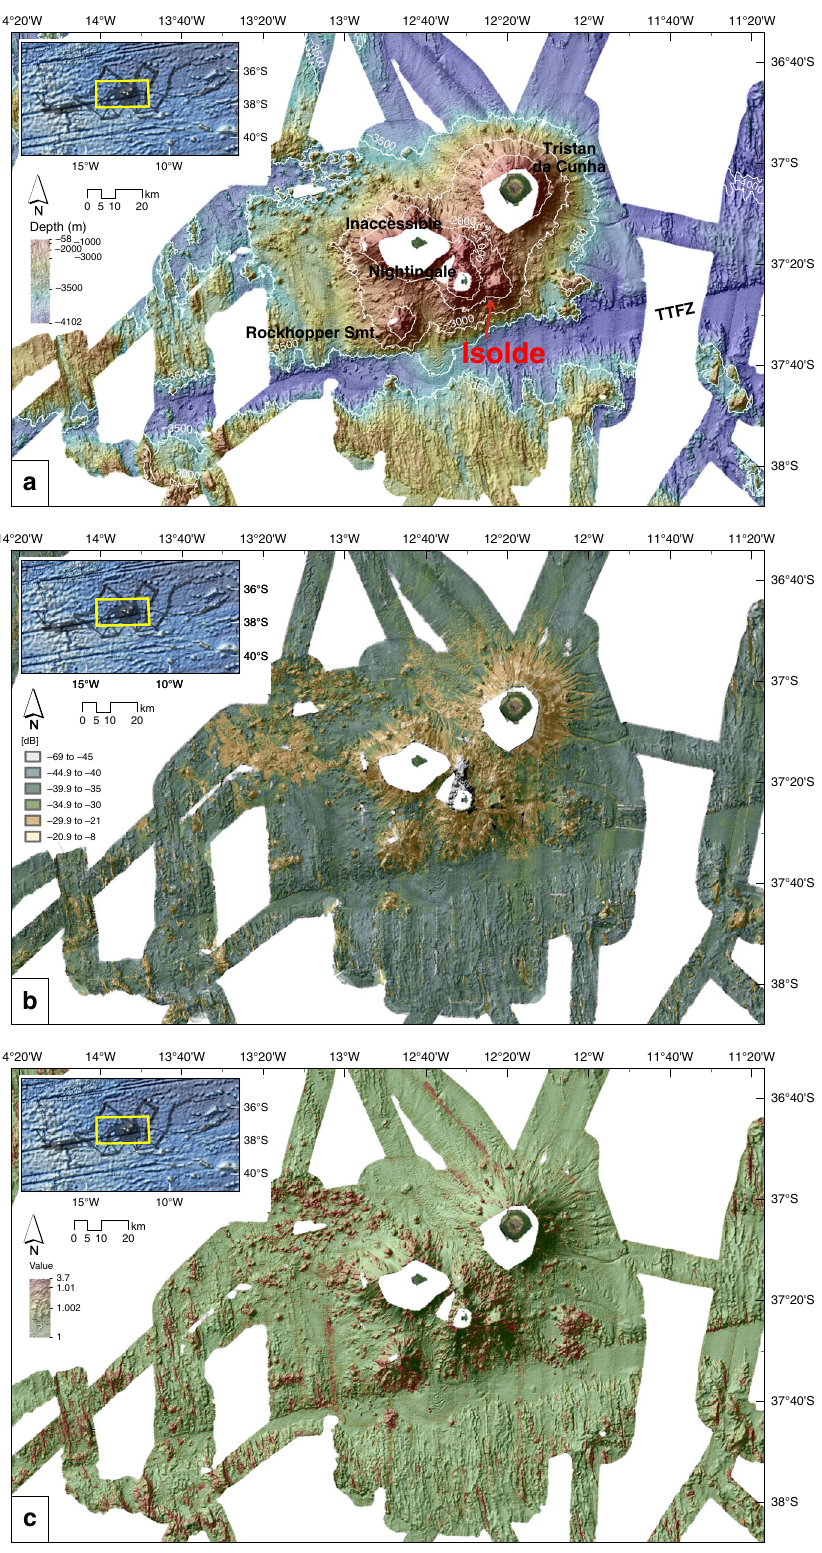
Fig. 3 Central area bathymetry, backscatter, rugosity. a Bathymetry for the central area. The hillshade is illuminated by an azimuth of 315°. The newly discovered Isolde and Rockhopper Seamounts (Smt.) lie south and southwest of Tristan da Cunha. b Seabed backscatter classi fi cation based on histogram natural breaks [dB]. Unclassi fi ed greyscale version in Supplementary Fig. 3a. c Rugosity after DuPreez 63 . TTFZ Tristan da Cunha Transform Fault And Fracture Zone